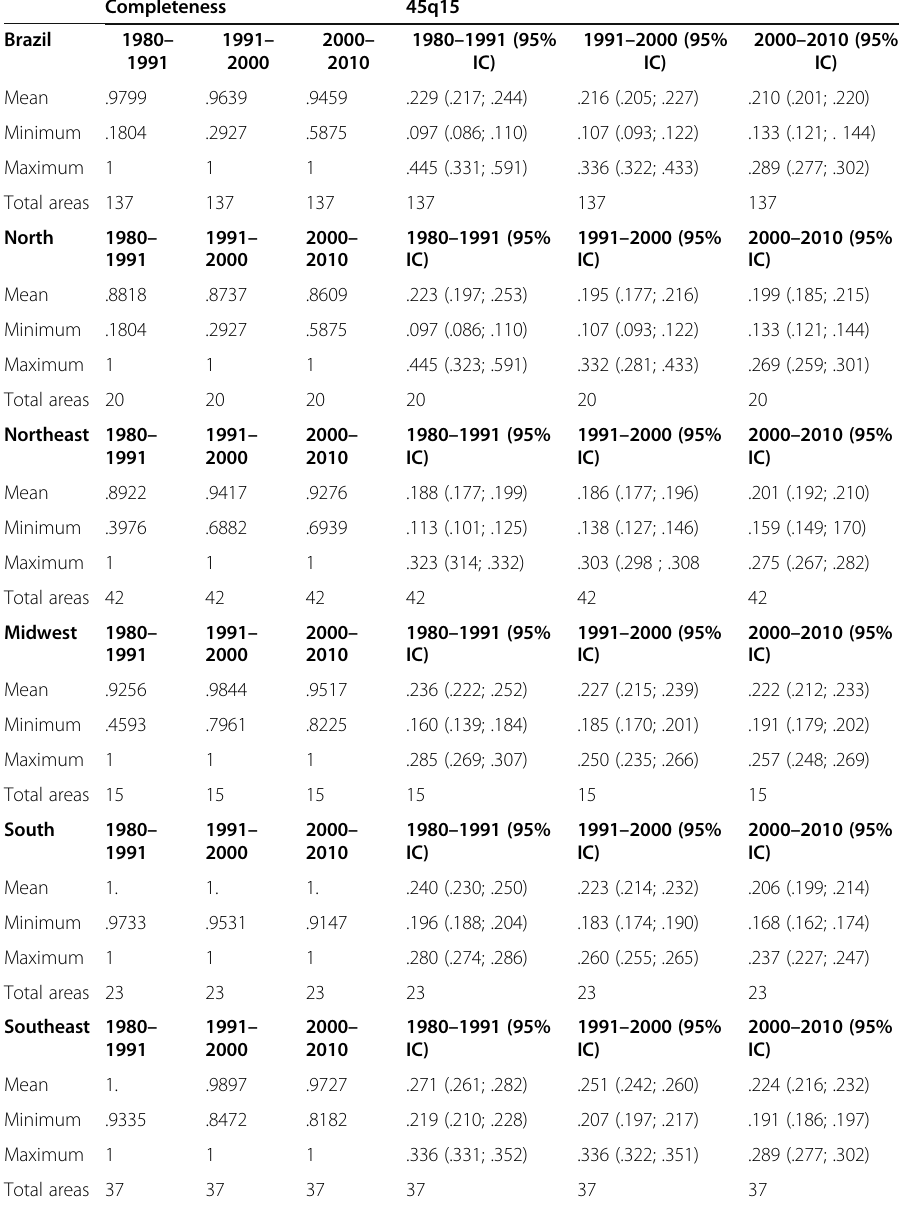
Table 2 Completeness of Death Counts and Adult Mortality Rates, Males, Brazil, and regions, 1980